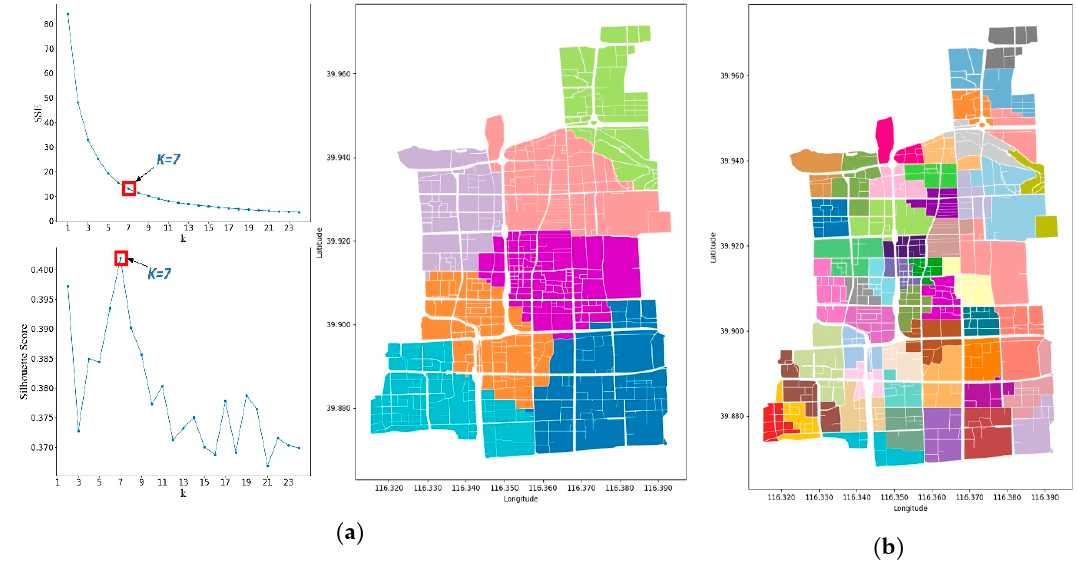
Figure 21. Illustration of contrast experiment results: ( a ) k-means ++ result (k = 7), the left parts of the figures illustrate the process of choosing the optimal cluster number; ( b ) k-means ++ result (k =